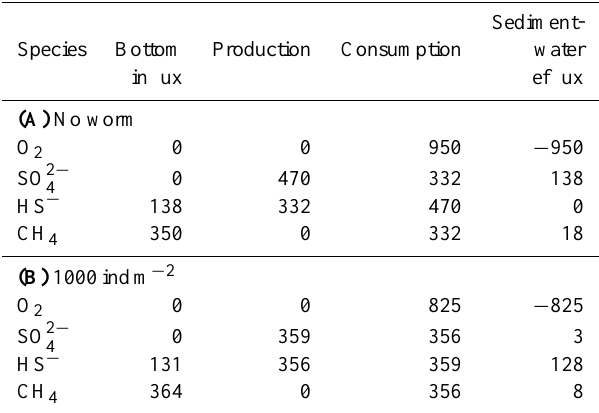
Table 3. Biogeochemical budgets of oxygen, sulfate, sulfide and methane in the absence of a worm (A) , and for low worm densities (B) . Units of nmolcm − 2 d − 1 .